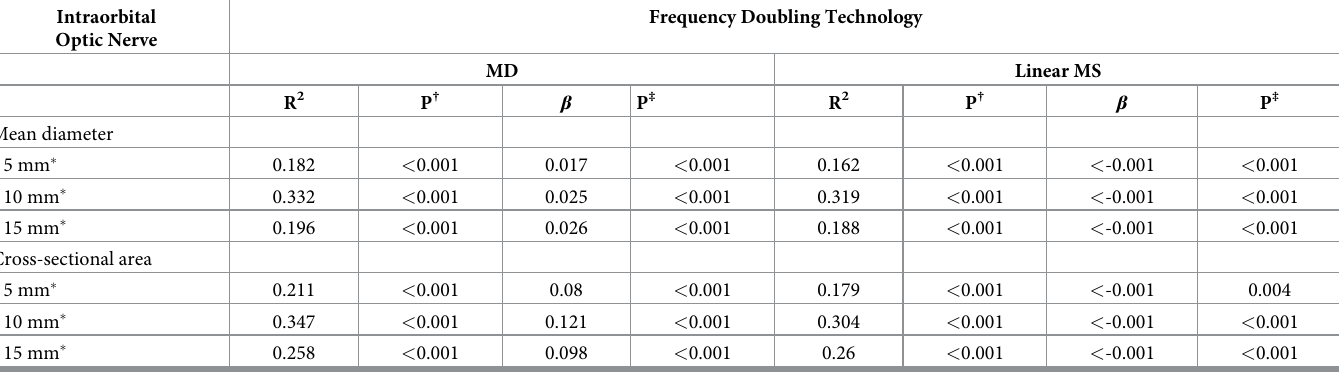
Cross-sectional